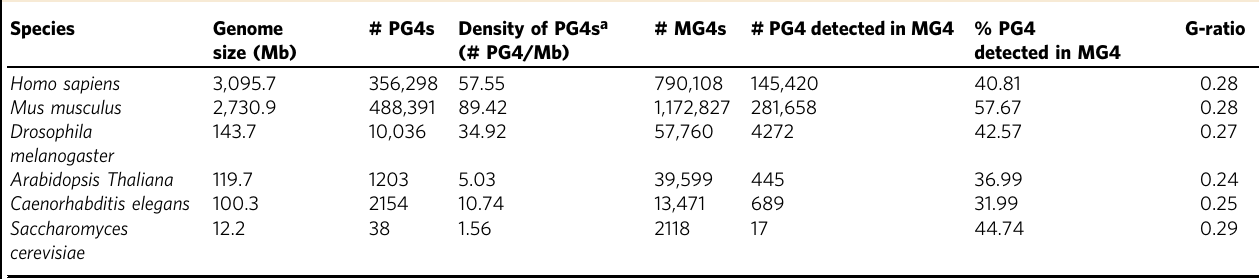
Table 2 MG4s detected for the six species using public